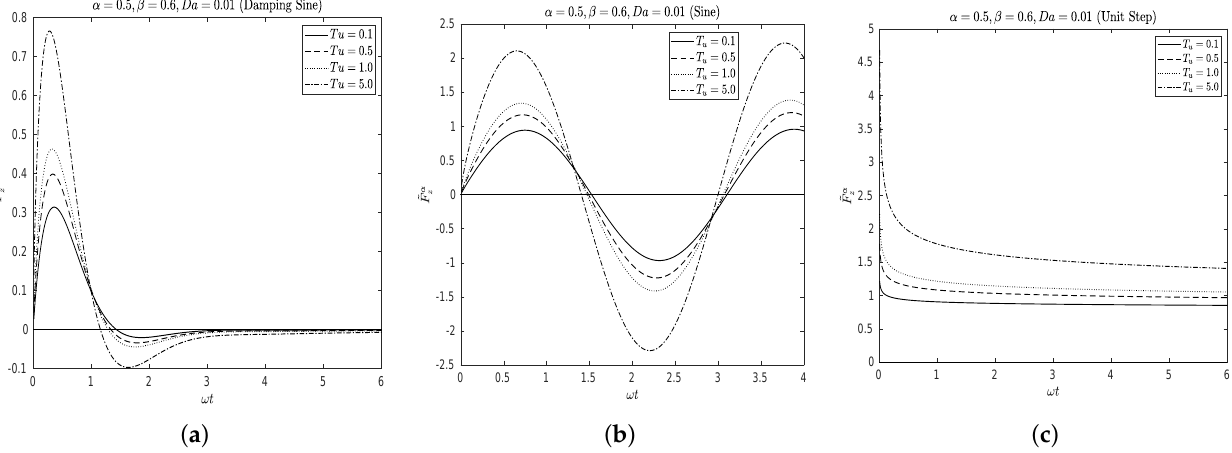
Figure 5. Variation of drag force at different T u for all three cases: ( a ) damping sine oscillation, ( b ) sine oscillation, ( c ) Unit step